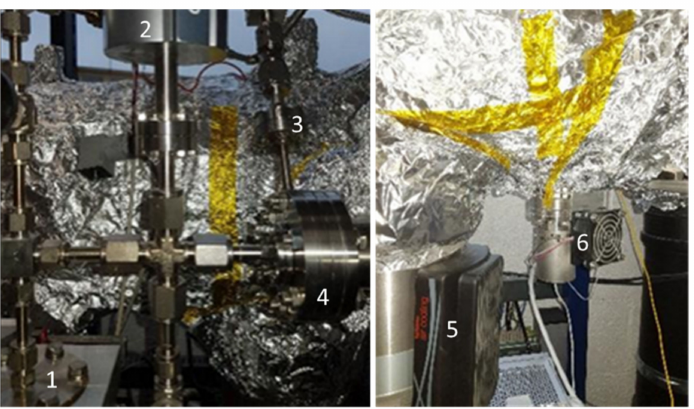
Figure 8. Membrane installation feature (1), pressure P 1 and external gas line to be sampled (2), BA gauge for P fin pressure (3), turbo-molecular pump (4), capacitive gauge for P 1 (5), and P fin on the membrane low-pressure side